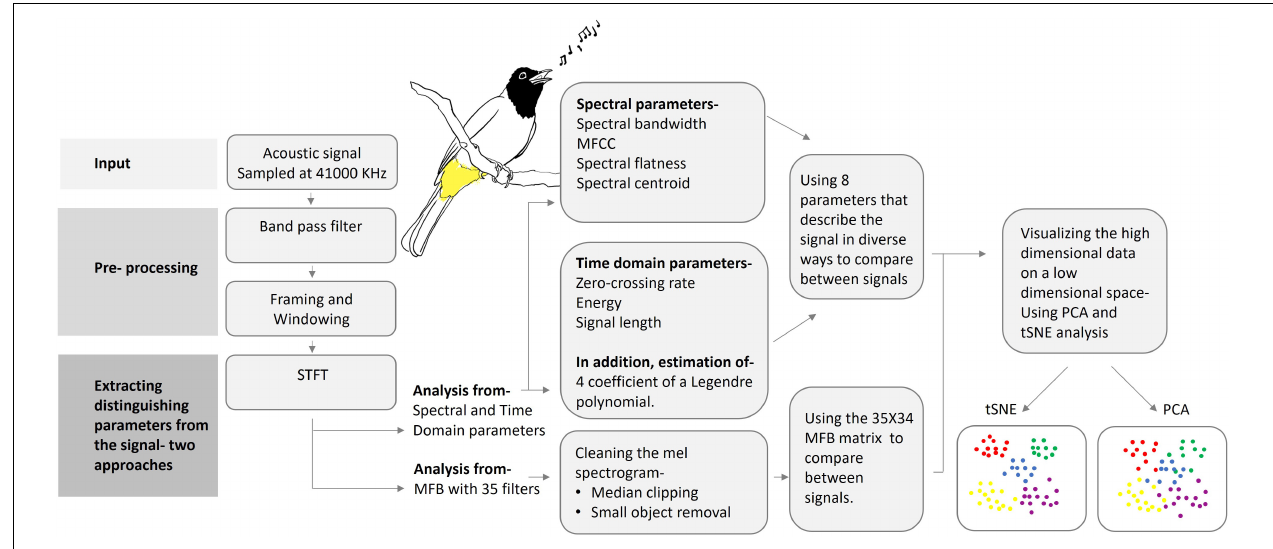
FIGURE 1 | A schematic block diagram of the audio analysis process: from pre-processing to data reduction and visualization. (Artwork by Aya Marck).